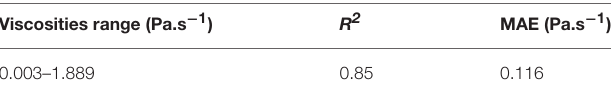
TABLE 8 | Results of the K-fold cross validation ( K = 5) method for the viscosities